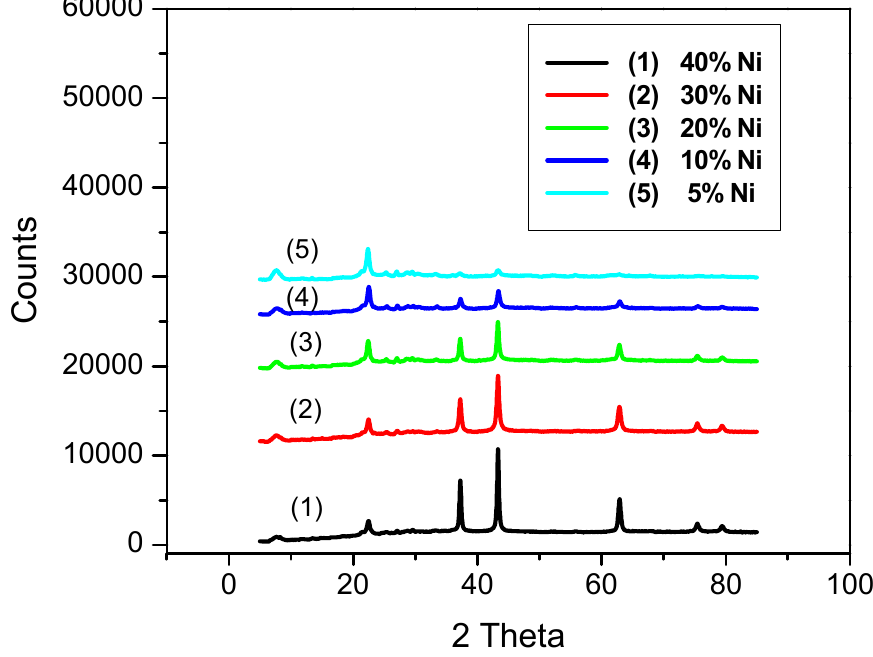
Figure 1. X-ray diffraction patterns of Ni/H β -zeolite catalysts with increasing nickel loading.